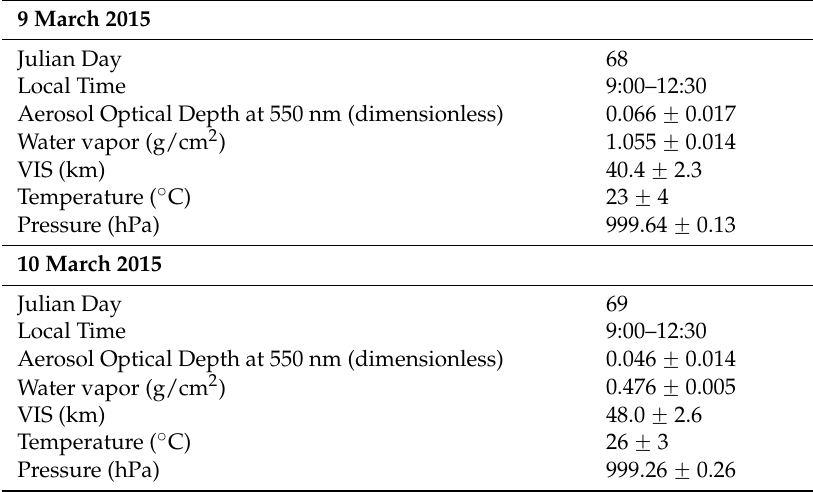
Table 5. Summary of atmospheric conditions.